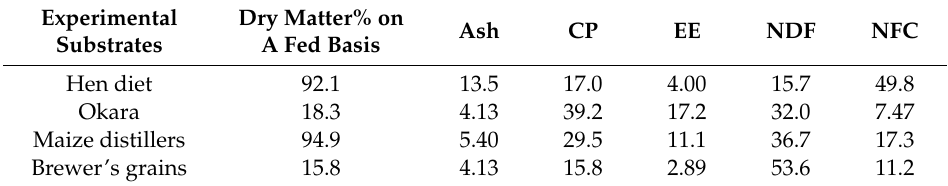
Table 2. Dry matter, ash, crude protein (CP), ether extract (EE), neutral detergent fiber (NDF) and non-fibrous carbohydrate (NFC) concentrations (% on DM) of the experimental substrates unless stated di ff